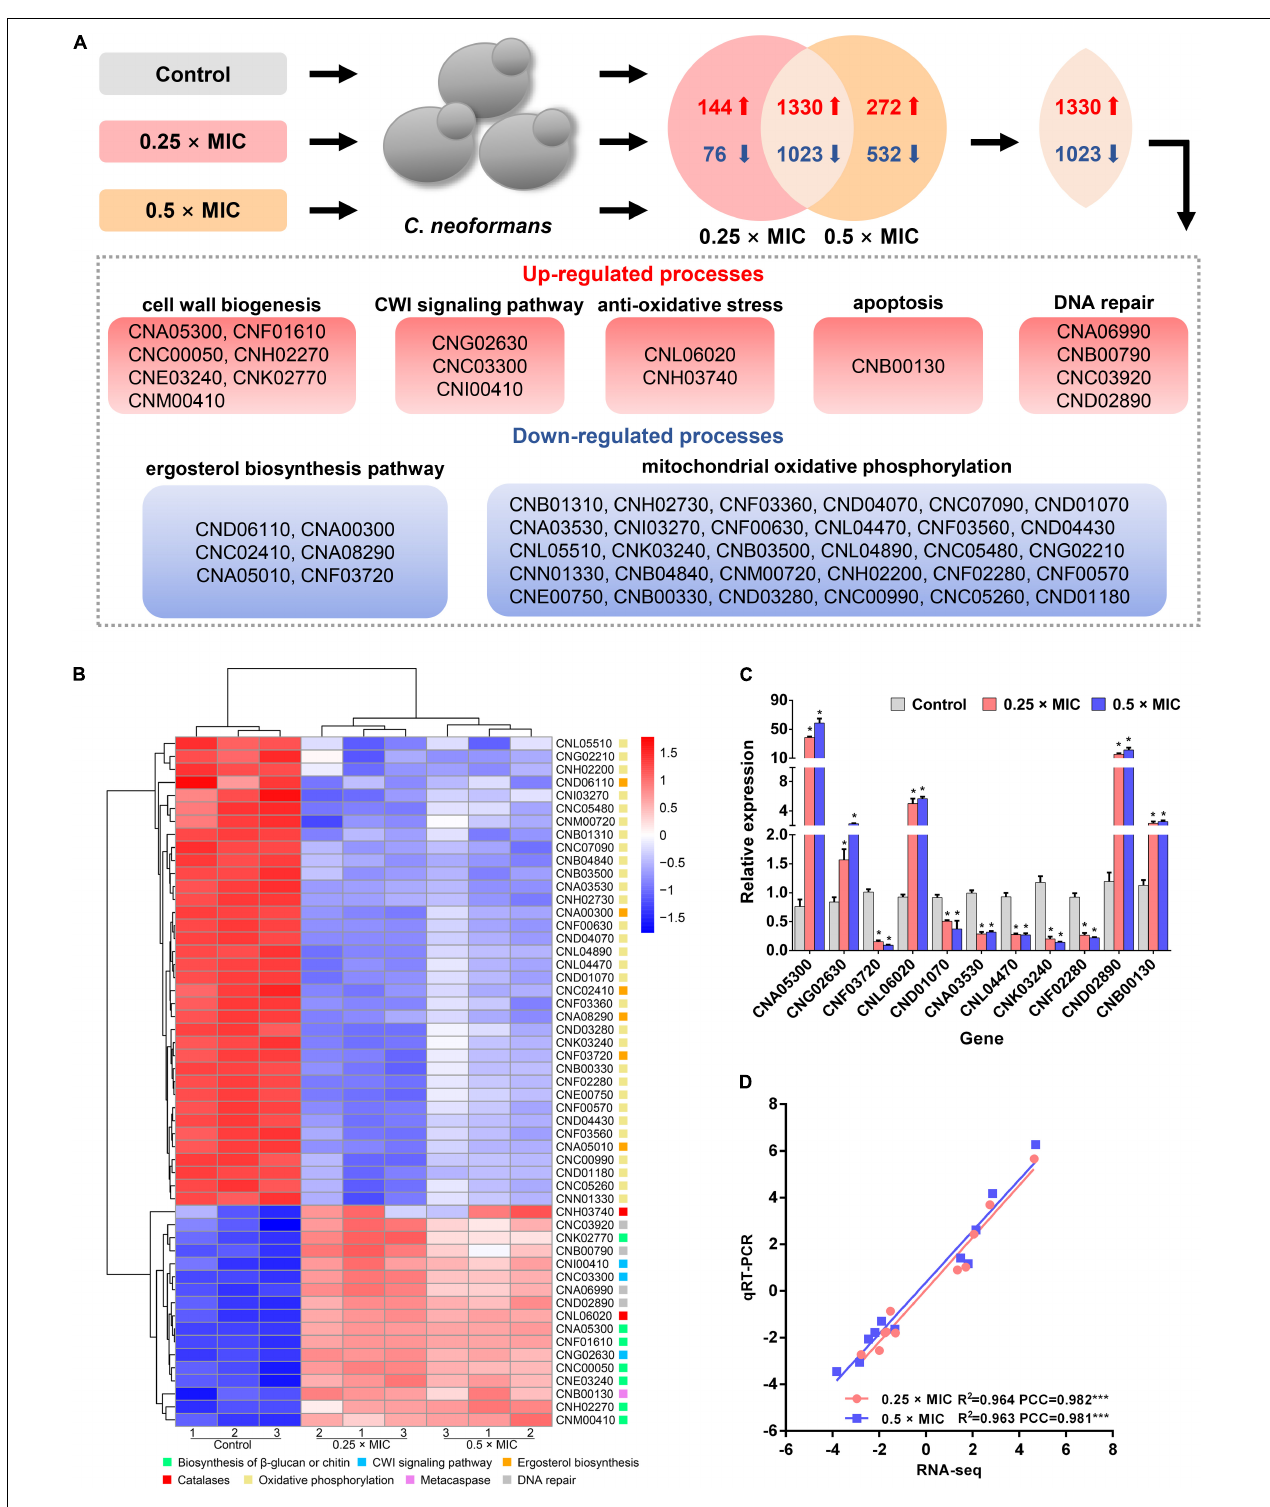
FIGURE 3 | Transcriptomic analysis of Sparamosin 26 − 54 -treated C. neoformans . (A) A common transcriptional response to different concentrations of Sparamosin 26 − 54 was identified by RNA-seq. (B) Heatmap of partial up-regulated and down-regulated genes. (C) Gene expression profiles of 11 DEGs in Sparamosin 26 − 54 -treated C. neoformans . Significant difference between control group and Sparamosin 26 − 54 treatment group was indicated by asterisks as * p < 0.05. (D) Correlation analysis between qRT-PCR and RNA-Seq results. PCC, Pearson correlation coefficients. *** p < 0.001.